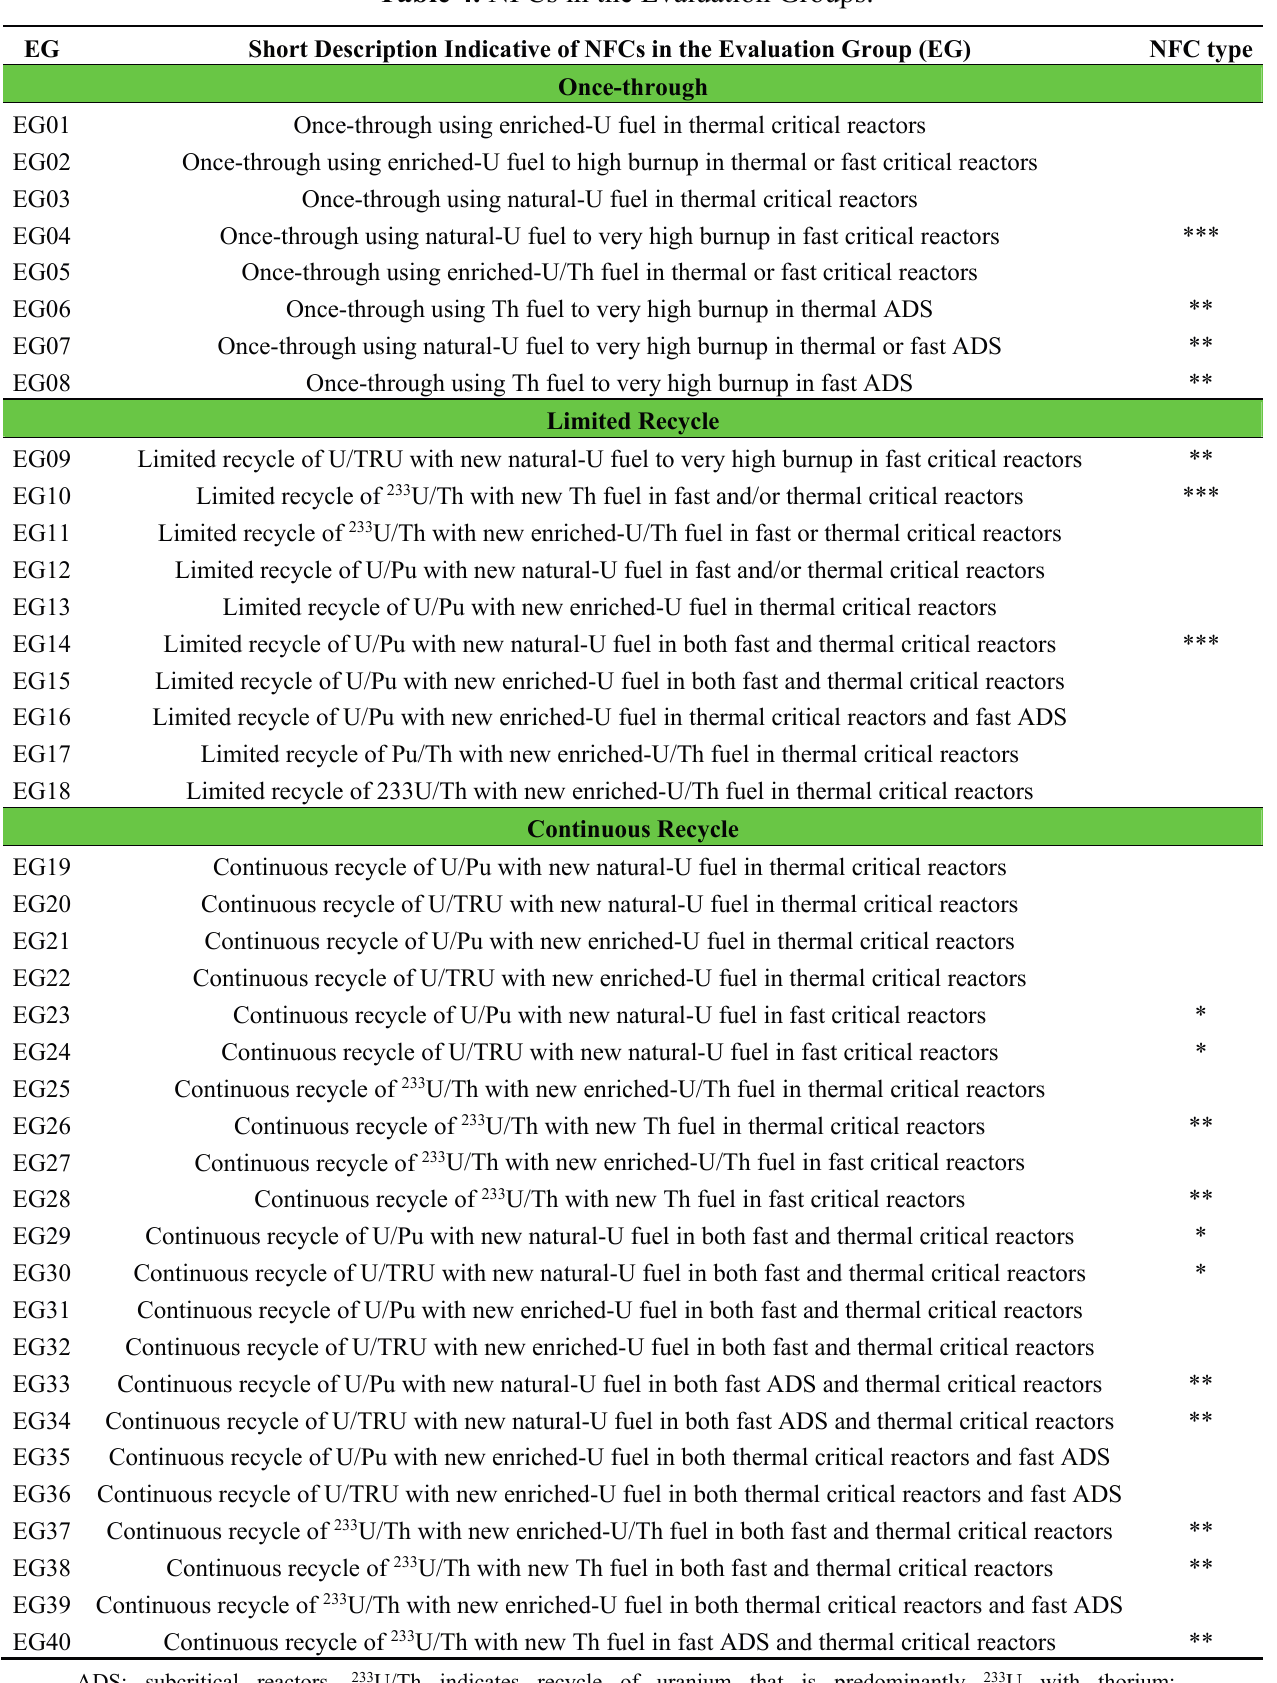
Table 4. NFCs in the Evaluation